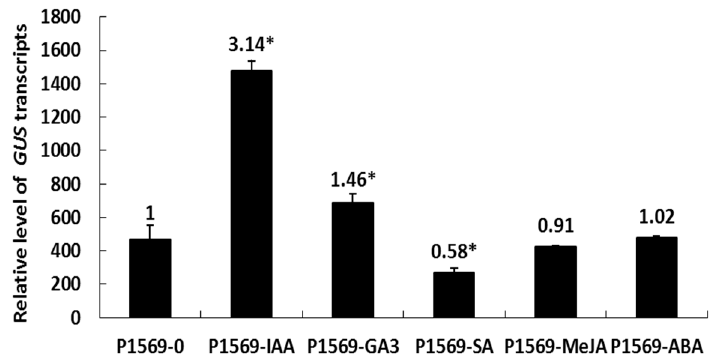
Figure 6. Response of the DlRan3B promoter to plant hormones. Tobacco leaves infiltrated with the construct P1569 were under the treatments of 8.6 μ M IAA, 34.6 μ M GA 3 , 75 μ M SA, 100 μ M MeJA, 75.7 μ M ABA, and water, as a control. Data are shown as means ± SD ( n = 3). Numbers over the bars represent the fold induction of the five plant hormone treatments over the control; the level of significant differences in contrast to the control (P1569-0) are indicated with an asterisk (*) and were assessed by a one-way ANOVA test (* p < 0.05).